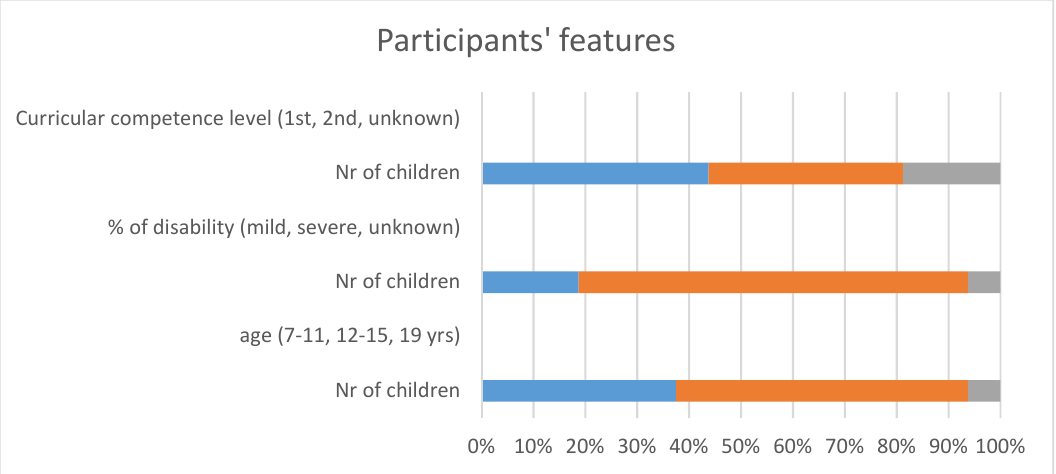
Figure 7. Participants’ features.